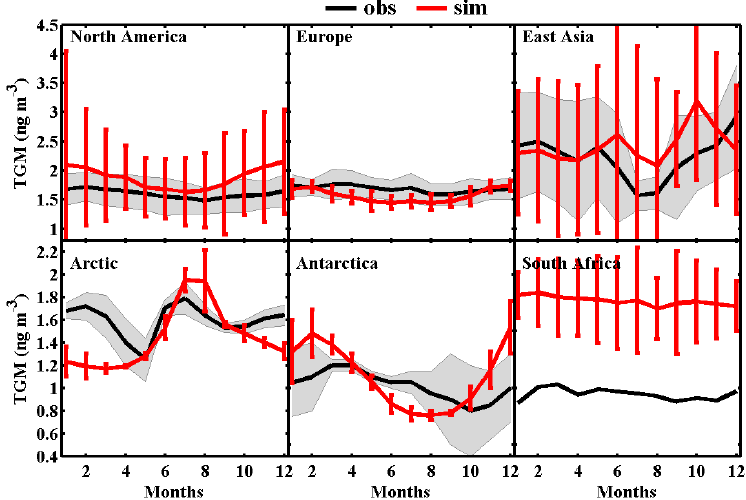
Figure 5. Mean seasonal variation of TGM (ngm − 3 ) over North America, Europe, East Asia, the Arctic, Antarctica and South Africa sites. Gray shaded areas and red vertical bars show 1 standard deviation over the sites for observations and for model